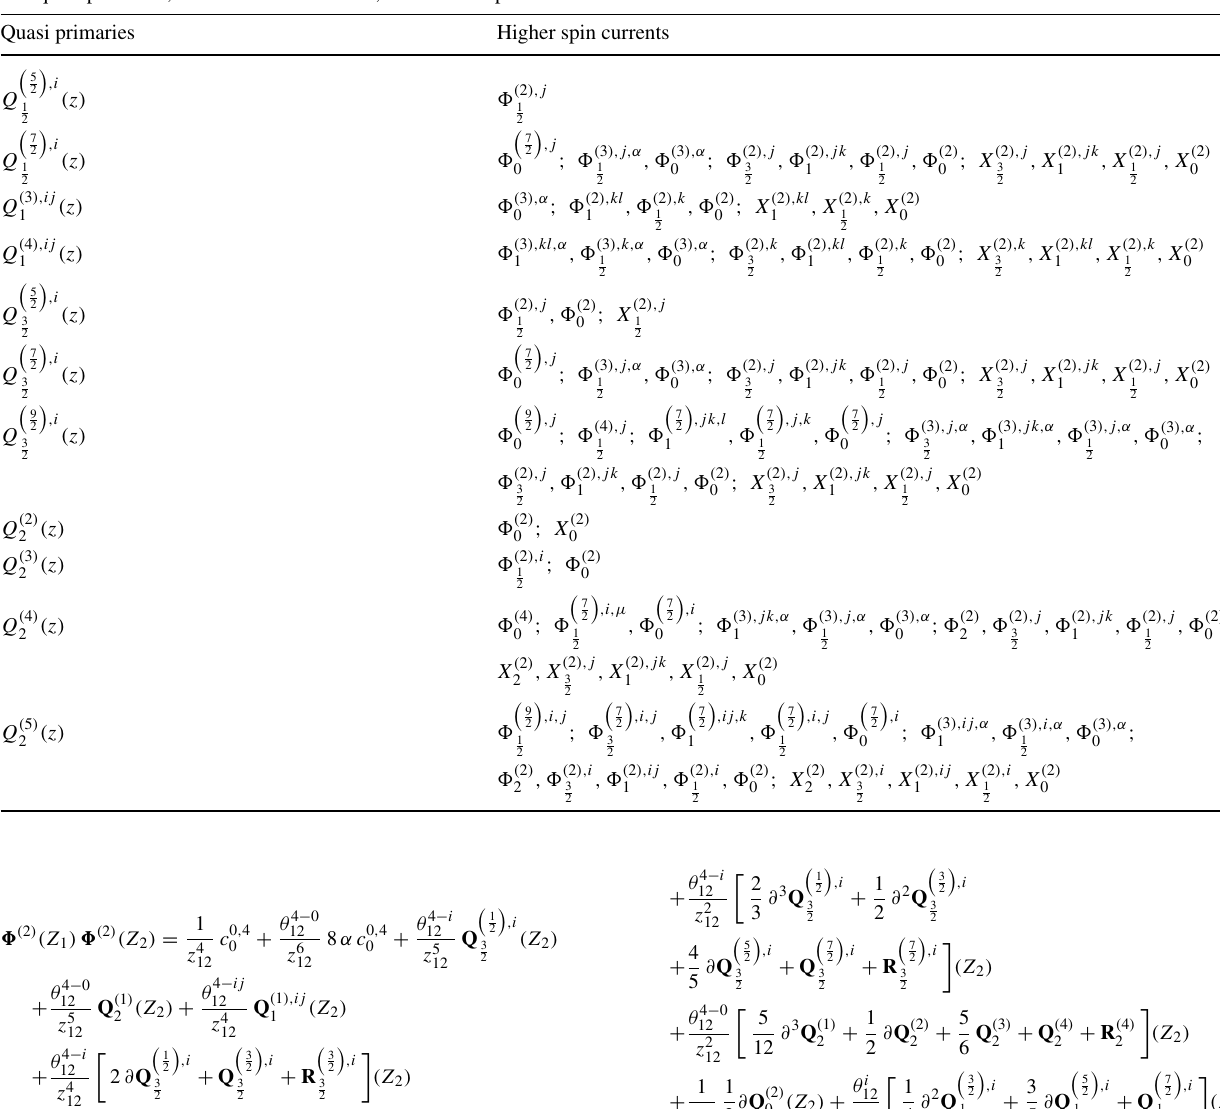
appears in front of the 4 )( 2 )